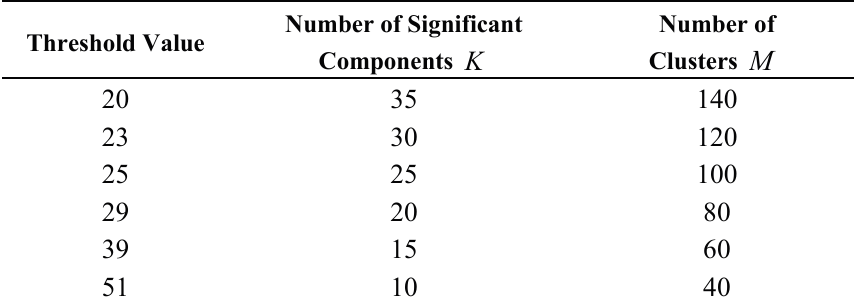
Table 2. Relationship of M , K and threshold